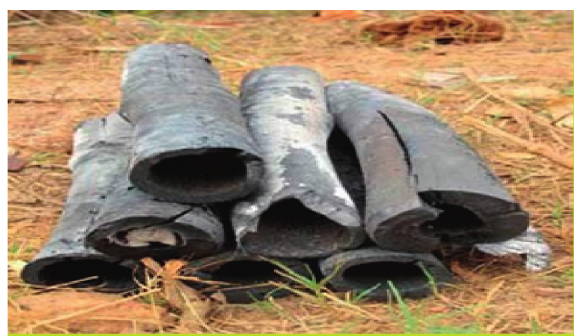
Figure 9: Bamboo charcoal making in Ethiopia (source: [22]).